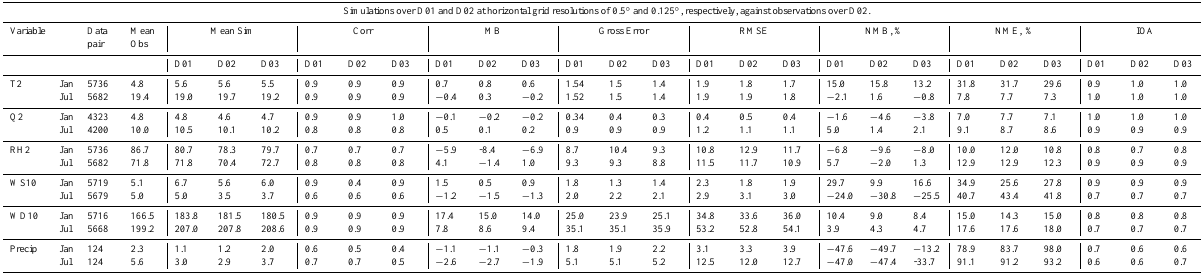
Table 4c. Comparison of performance statistics of WRF in January and July 2001 1 , 2